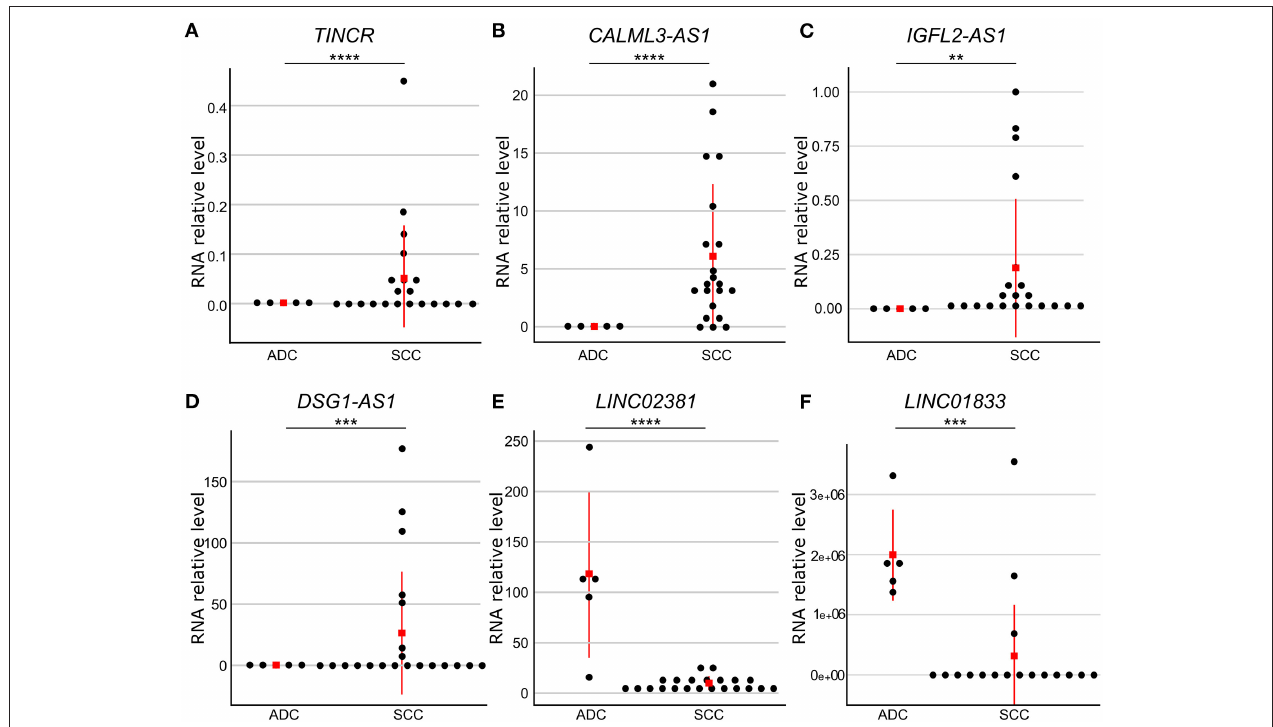
FIGURE 3 | Gene expression levels of six differently expressed long non-coding RNA (lncRNA) genes between cervical adenocarcinoma (ADC) and squamous cell carcinoma (SCC). RNA levels were evaluated by quantitative reverse transcriptase-polymerase chain reaction (qPCR) and normalized to RPLP0 gene levels in SCC ( n = 25) and ADC ( n = 5) samples. Red square indicates median value. Gene expression levels were significantly different using Mann–Whitney test ( p ≤ 0.05). TINCR (A) , CALML3-AS1 (B) , IGFL2-AS1 (C) , and DSG1-AS1 (D) lncRNA genes presented higher expression levels in cervical SCC as compared with ADC, whereas